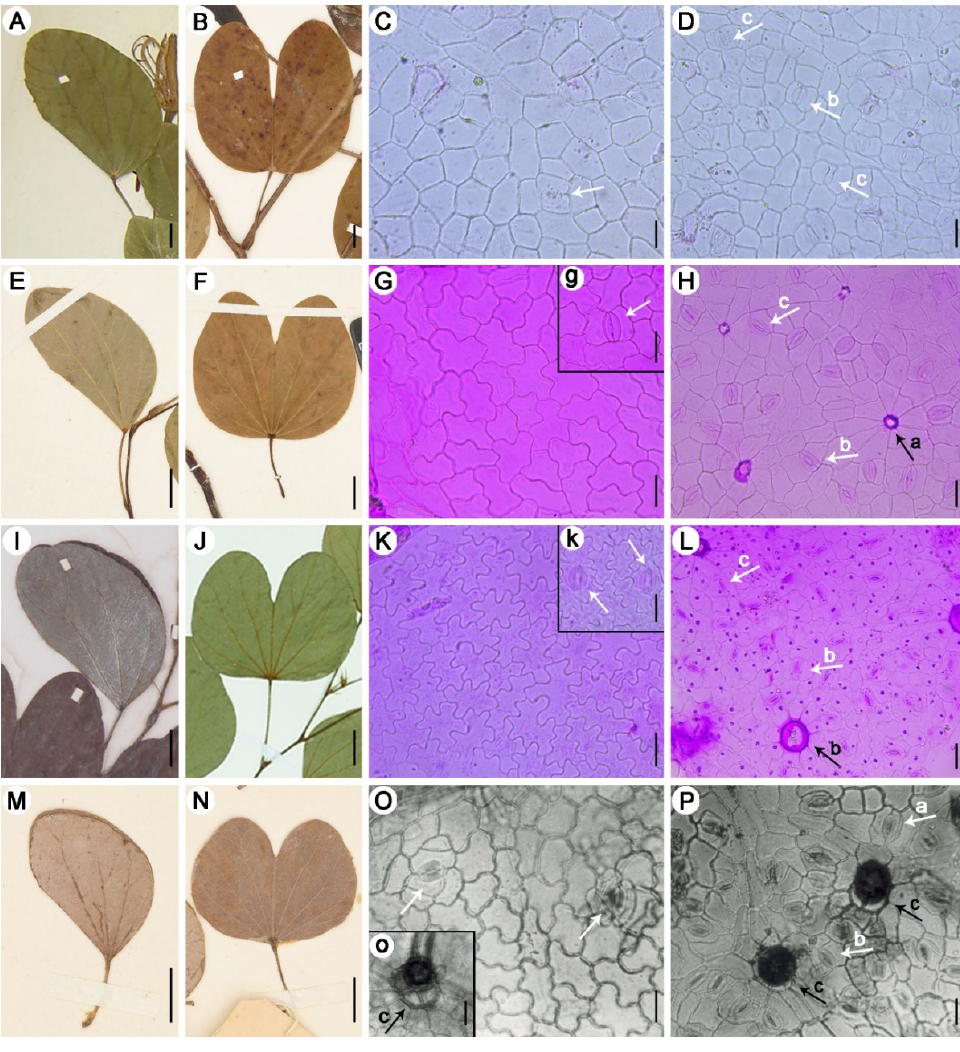
Figure 9. Leaf morphologies, together with adaxial ( C , G , K , O ) and abaxial ( D , H , L , P ) epidermises of Bauhinia purpurea L. ( A – D ) ((A) PE, 00327078; (B) KUN, 0125154), B . viridescens Desv. ( E – H ) (KUN 0169829), B . tomentosa L. ( I – L ) (( I ) SYS, 00044882; ( J ) HITBC, 0021440), and B . racemosa Lam. ( M – P ) (KUN, 0125165). The scale bars represent 1 cm for leaf specimens and 20 μ m for epidermal images. The image g in G indicates a stomatal complex of an adaxial epidermis. The image k in K indicates stomata of an adaxial epidermis. The image o in O indicates a trichome base of an adaxial epidermis. White arrows in C, g, k, and O indicate stomata of adaxial epidermises; white arrows in D, H, L, and P indicate (a) paracytic stomatal complex, (b) tetracytic stomatal complexes, and (c) sunken guard cells; black arrows indicate (a) a single-celled trichome base, (b) a single-celled glandular trichome base, and (c) multicellular trichome bases. Morphotypes 3 and 4, are similar to leaves and fruits of two species, i.e., Bauhinia touranensis Gagnep. and B . damiaoshanensis T. Chen (Figure 10). The two morphotypes possibly represent the same species, but this species is distinguished from those repre- sented by morphotypes 1 and 2 because the fruit (morphotype 4) is different from those